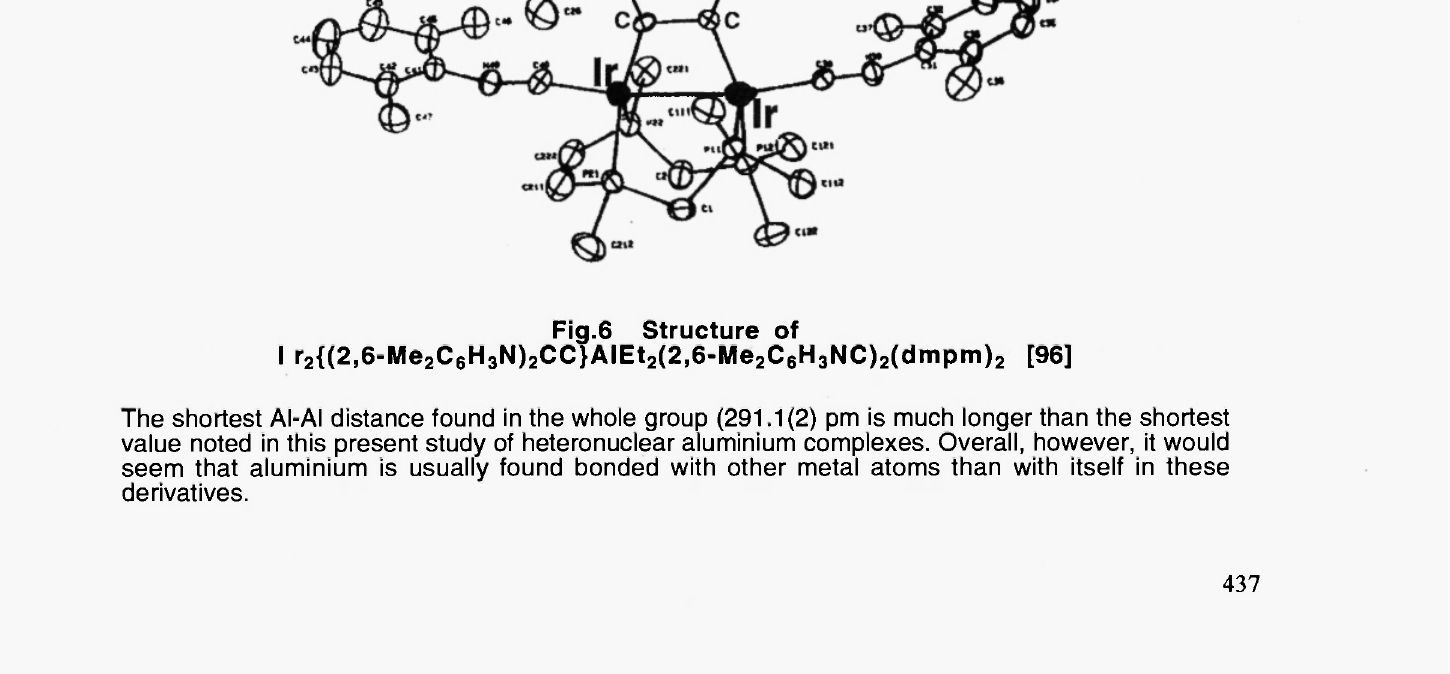
. Fig.5 Structure of